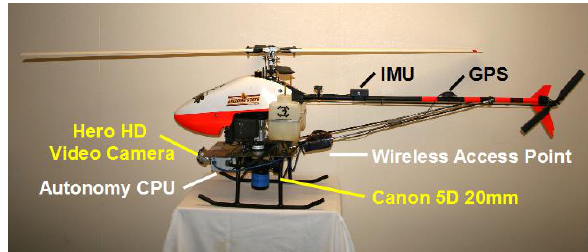
Figure 5: The SR30 platform with modifications and SFM equip- ment